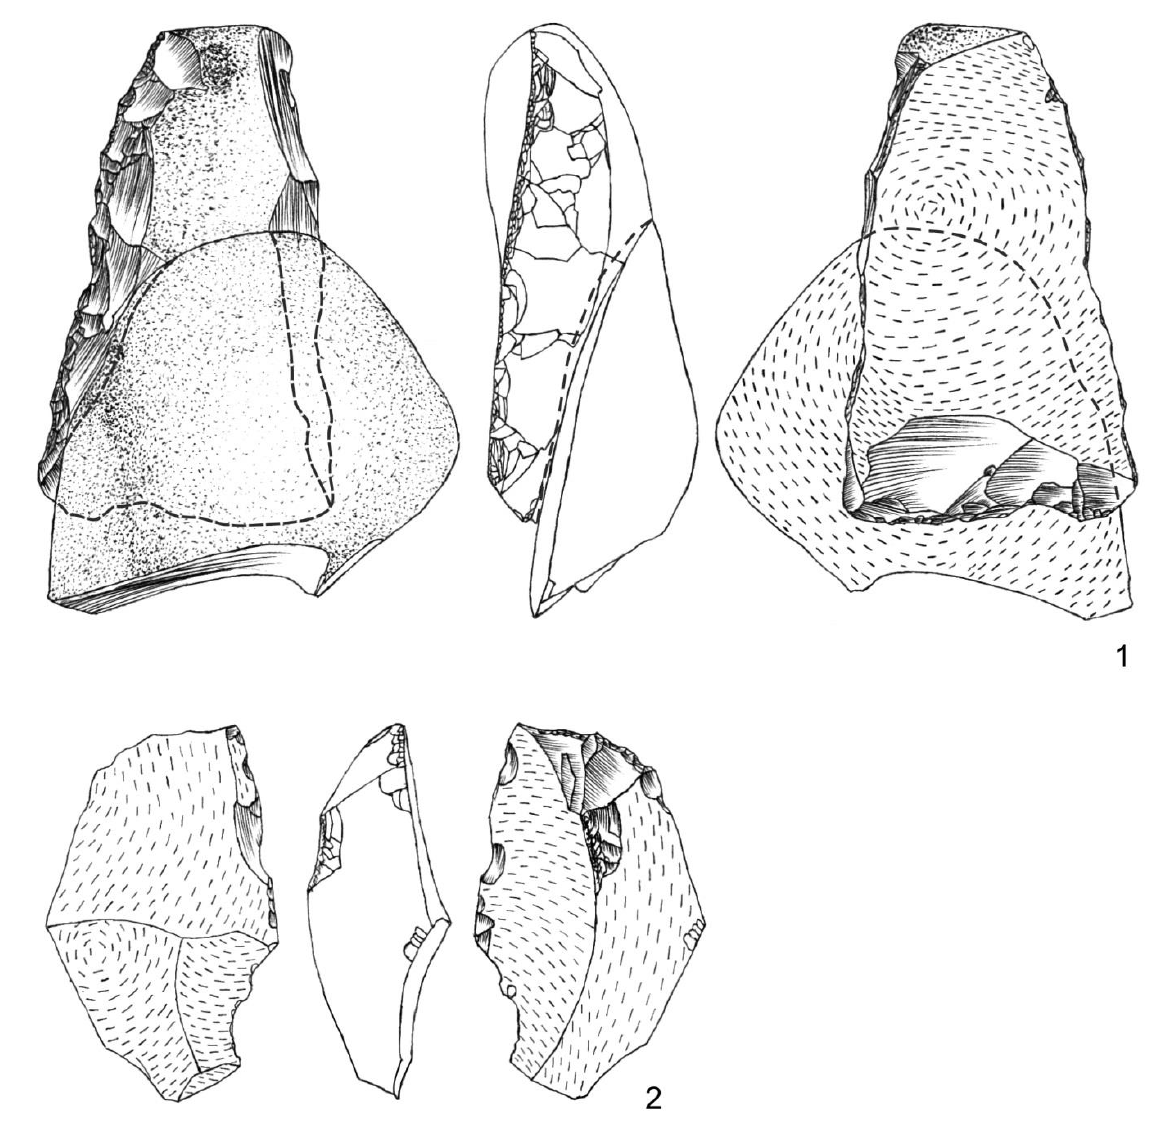
Figure 3. 1 – refit of a core axe blade with a natural chunk; 2 – endscraper. Drawn by P.